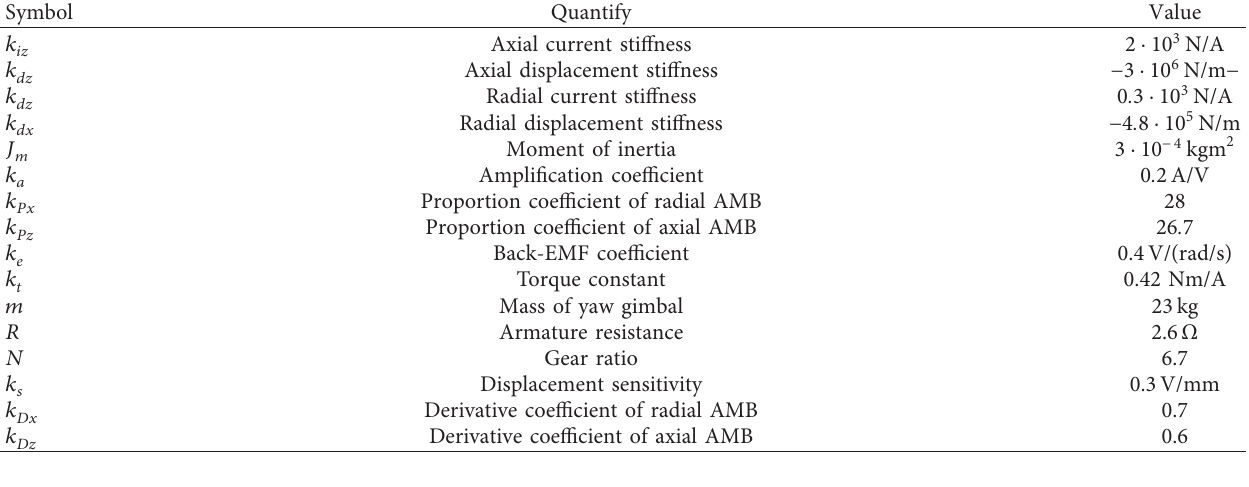
Table 1: Parameters of three-axis ISP with the AMB system.